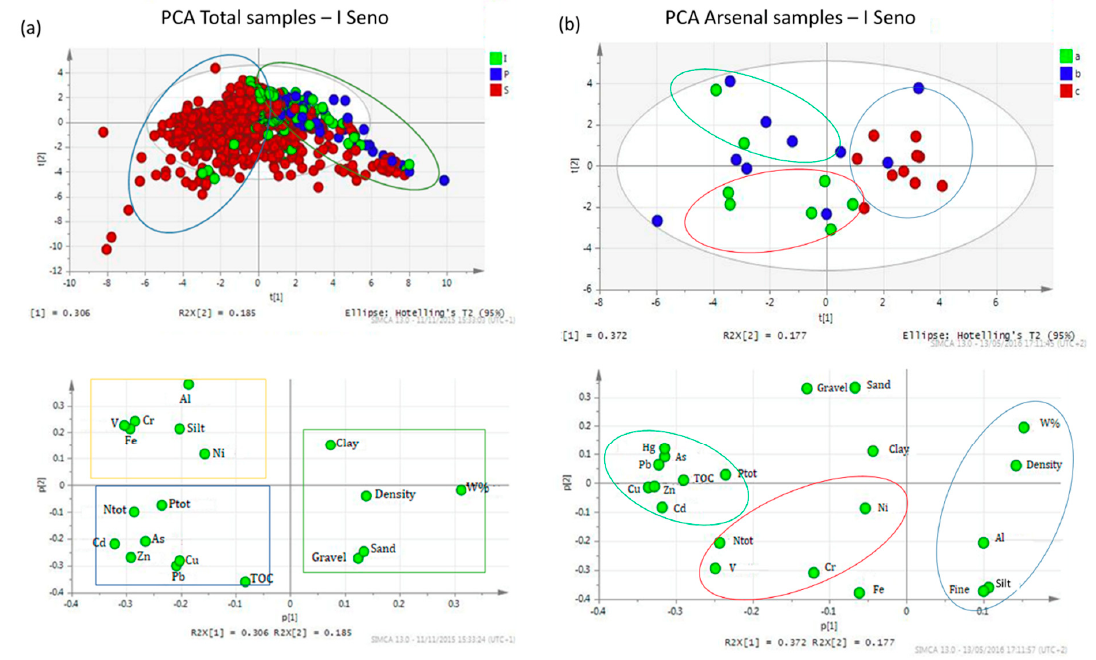
Figure 17. ( a ) Total dataset projection of Score plot (samples) and Loading plot (variables) on space PC1 / PC2; ( b ) Arsenal dataset projection of Score plot (samples) and Loading plot (variables) on space PC1 / PC2 (S = Surficial = layers 0–10 cm ( a ), 10–30 cm ( b ), 30–50 cm ( c ); I = Intermediate = layers 100–120 cm; P = Deep = layers 180–200 cm, 280–300 cm) [1].